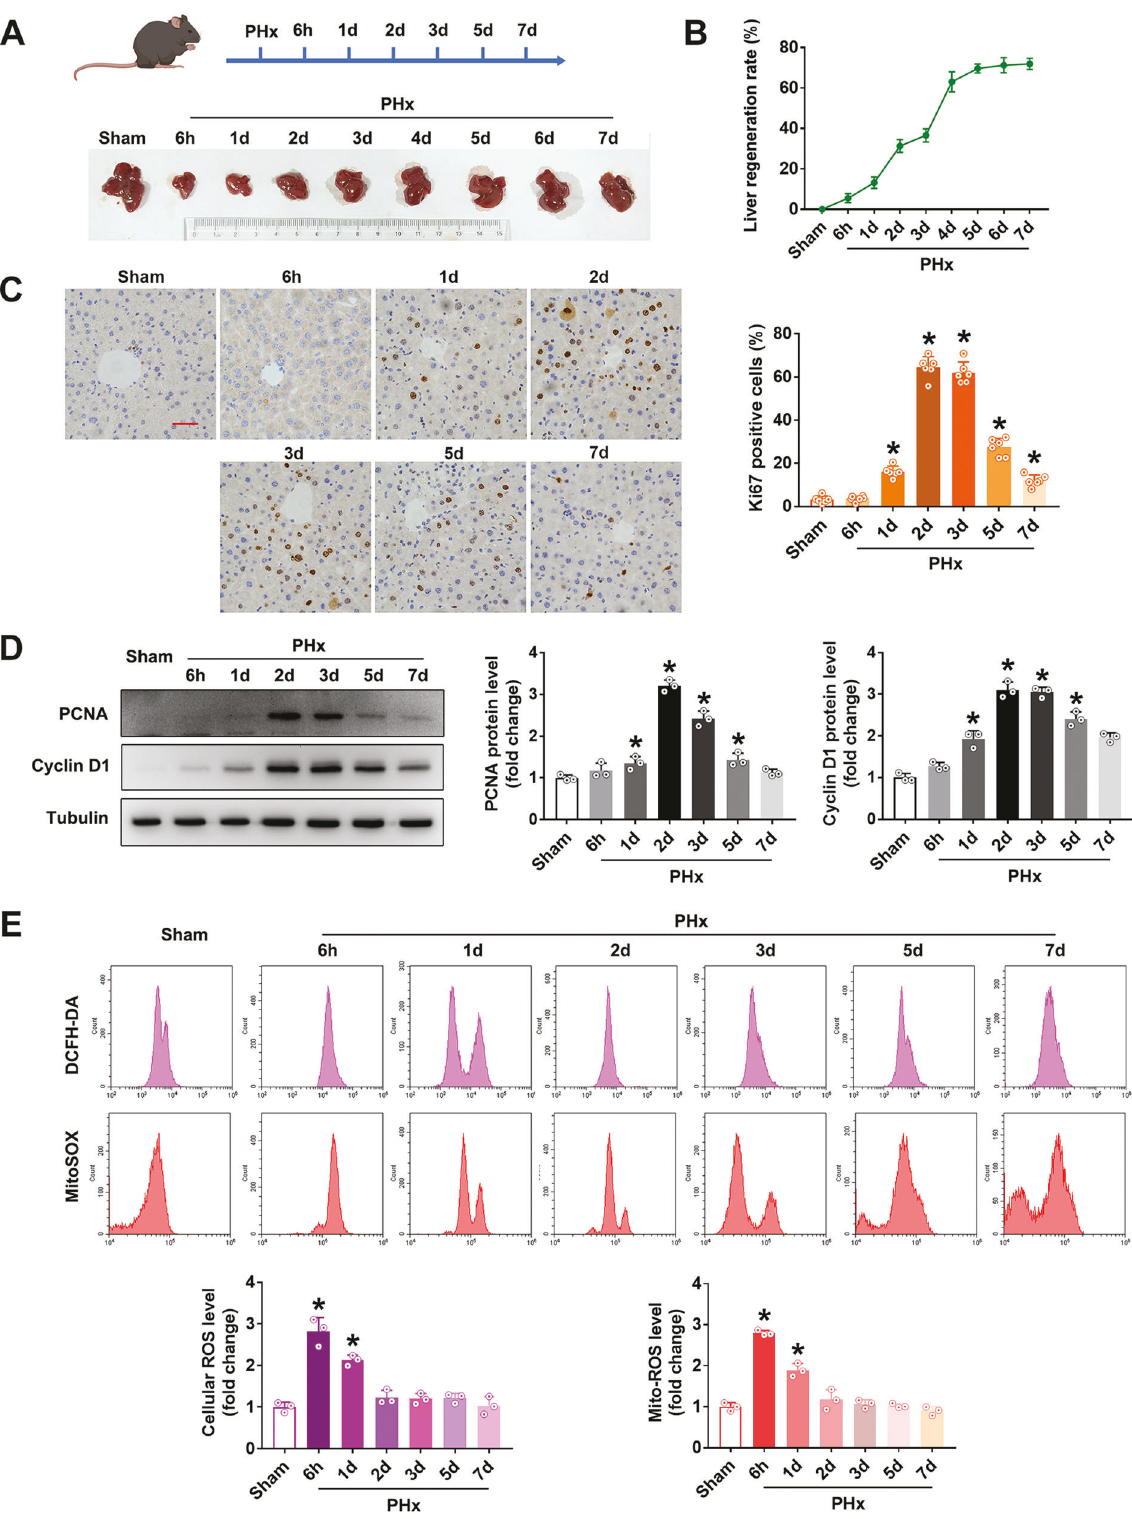
Fig. 1 Time course of liver regeneration (LR) and reactive oxygen species (ROS) production after 70% partial hepatectomy (PHx) in mice. Liver samples were taken, and LR and ROS production was determined at different time points (6 h, 1 d, 2 d, 3 d, 5 d, and 7 d) after the C57 mice were subjected to PHx. A Schematic representation of the experimental procedure and representative macroscopic images of remnant liver. B LR rate, n = 6. C Immunohistochemistry staining and quanti fi cation of Ki67, bar = 50 µm, n = 6. D Western blot analysis and quanti fi cation of PCNA and Cyclin D1 (three independent experiments). E Flow cytometry assay and quanti fi cation of cellular ROS (probed with DCFH-DA) and mitochondrial ROS (probed with MitoSOX) (three independent experiments). Data are shown as means ± SEM. * P < 0.05 vs Sham